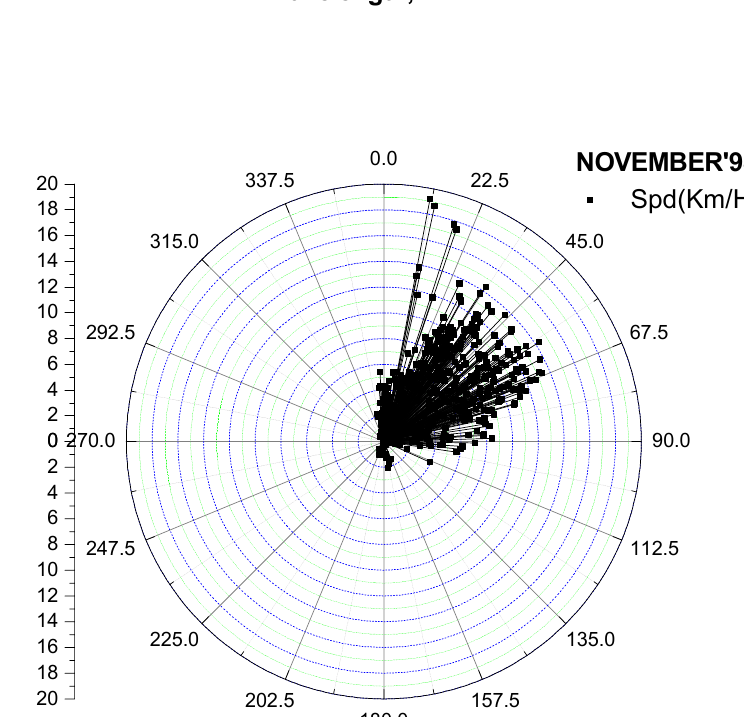
the usual secondary mode between 0.7–0.8 µ m is buried in the new mode at 0.4 µ m. When the column water vapour content is around 6.0 g/cm 2 , a decrease in number density at the large particle size (2 µ m and above) is seen (please see the bottom panel of Fig.